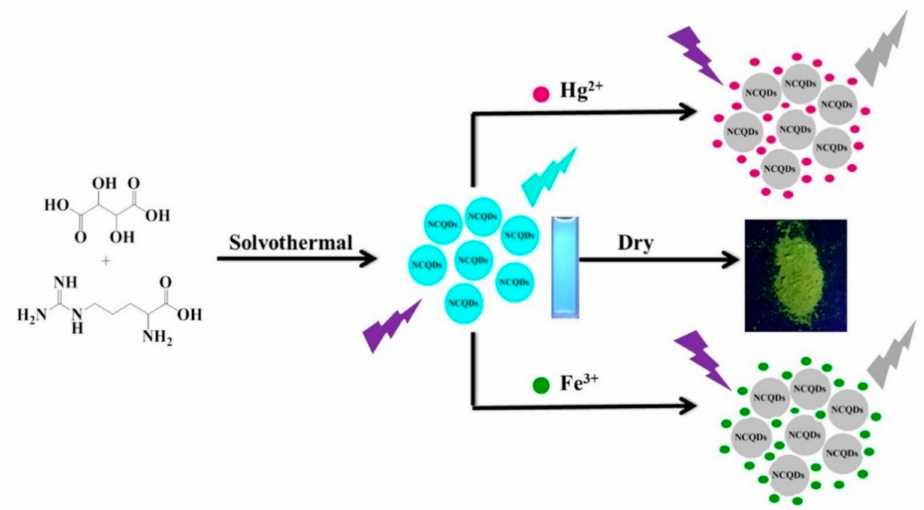
Figure 4. Schematic illustration of the preparation of N-CQDs using tartaric acid and L-arginine by a solvothermal method for dual sensing of Hg 2+ and Fe 3+ metal ions. Reprinted with permission from Ref. [100]. Copyright 2020